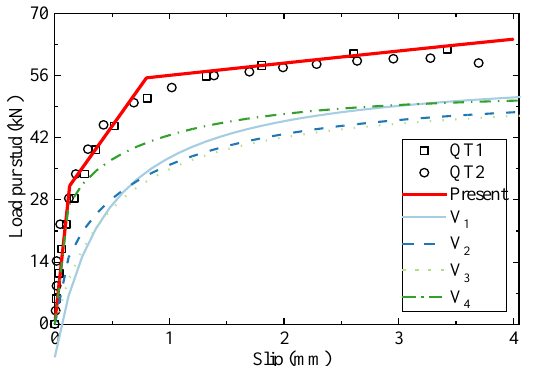
Figure 5. The comparison of load–slip curves between the test, empirical formulae, and the analytical method for QT1-2.